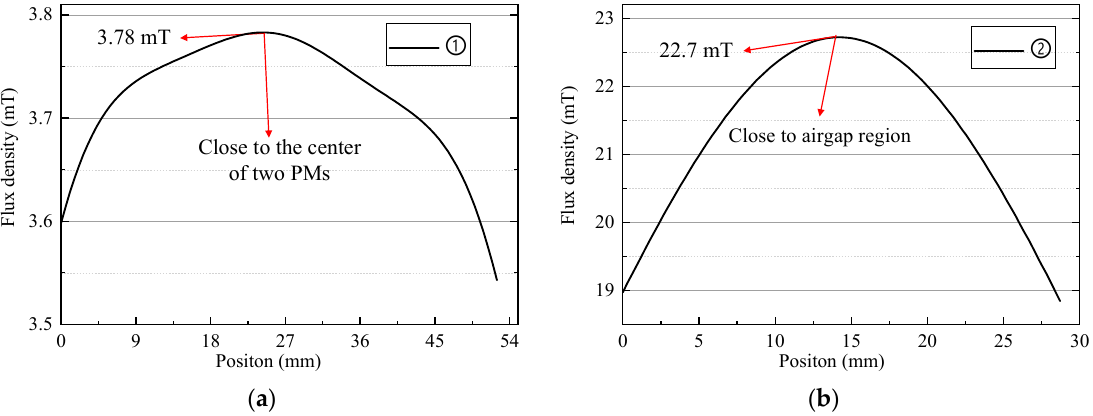
Figure 10. Flux density at the key positions close to the CubeSat: ( a ) driving unit of the conveying platform and ( b ) ejection unit of the launcher.